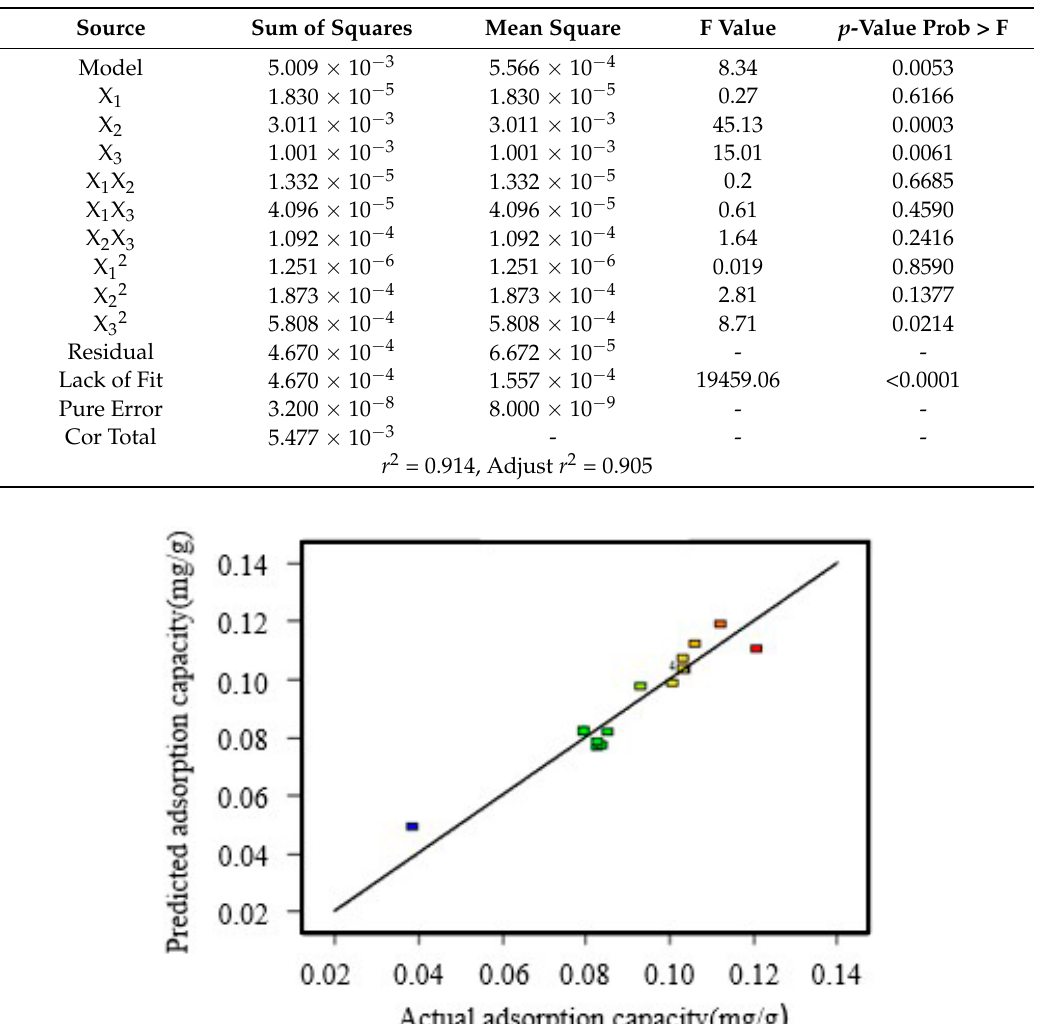
Table 8. The analysis of variance (ANOVA) results for the adsorption capacity of lime sand bricks towards Cu(II) (mg/g).